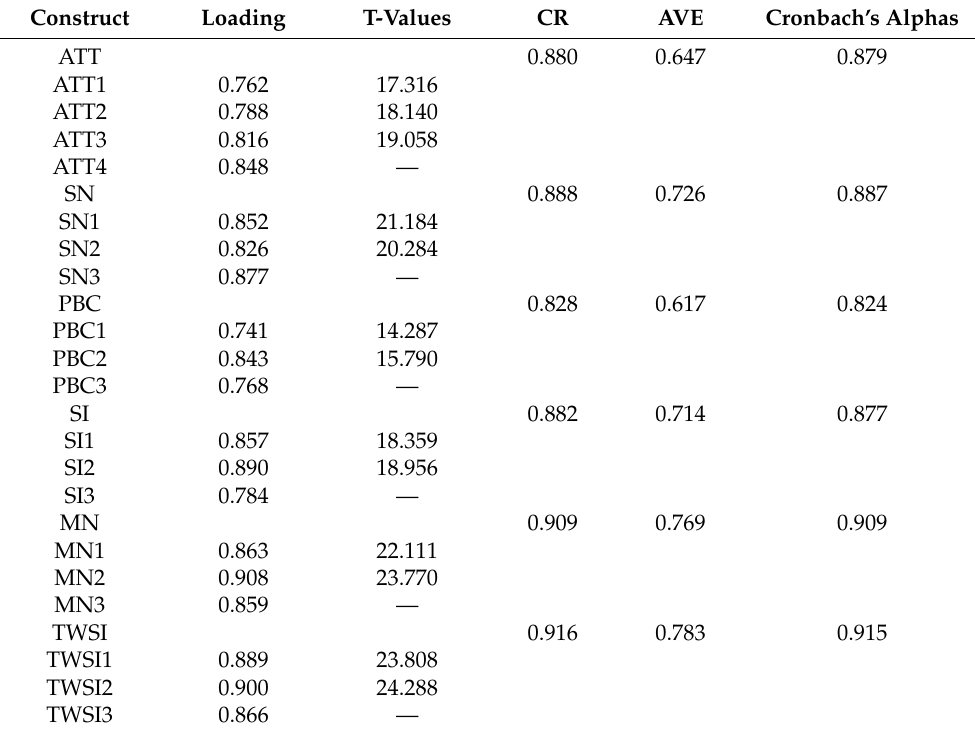
Table 2. Results of the measurement